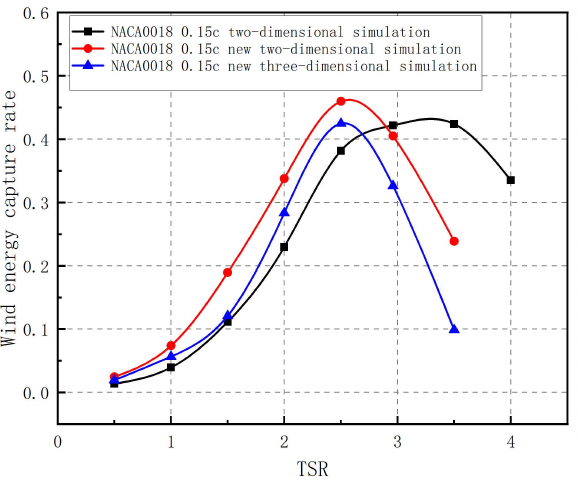
Figure 35. Wind energy capture rate of J-blade wind generator before and after optimization.